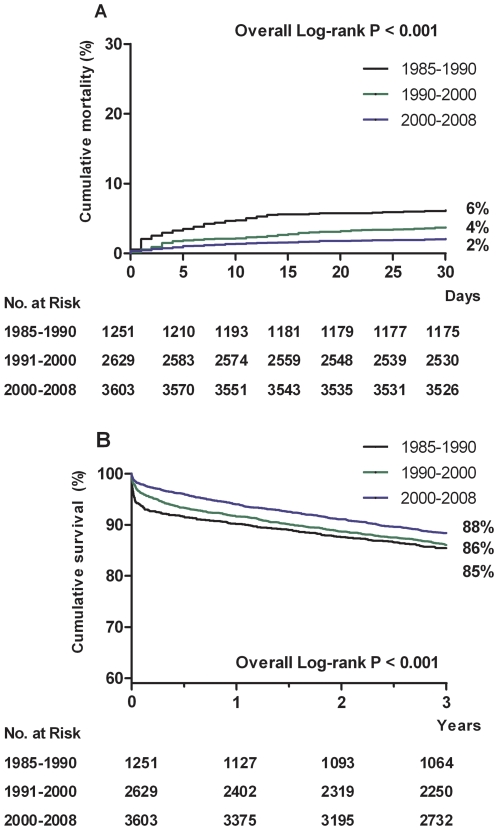
Kaplan-Meier curves for 30-day cumulative mortality or (Figure 4A) or three-year cumulative survival (Figure 4B) according to calendar period of admission